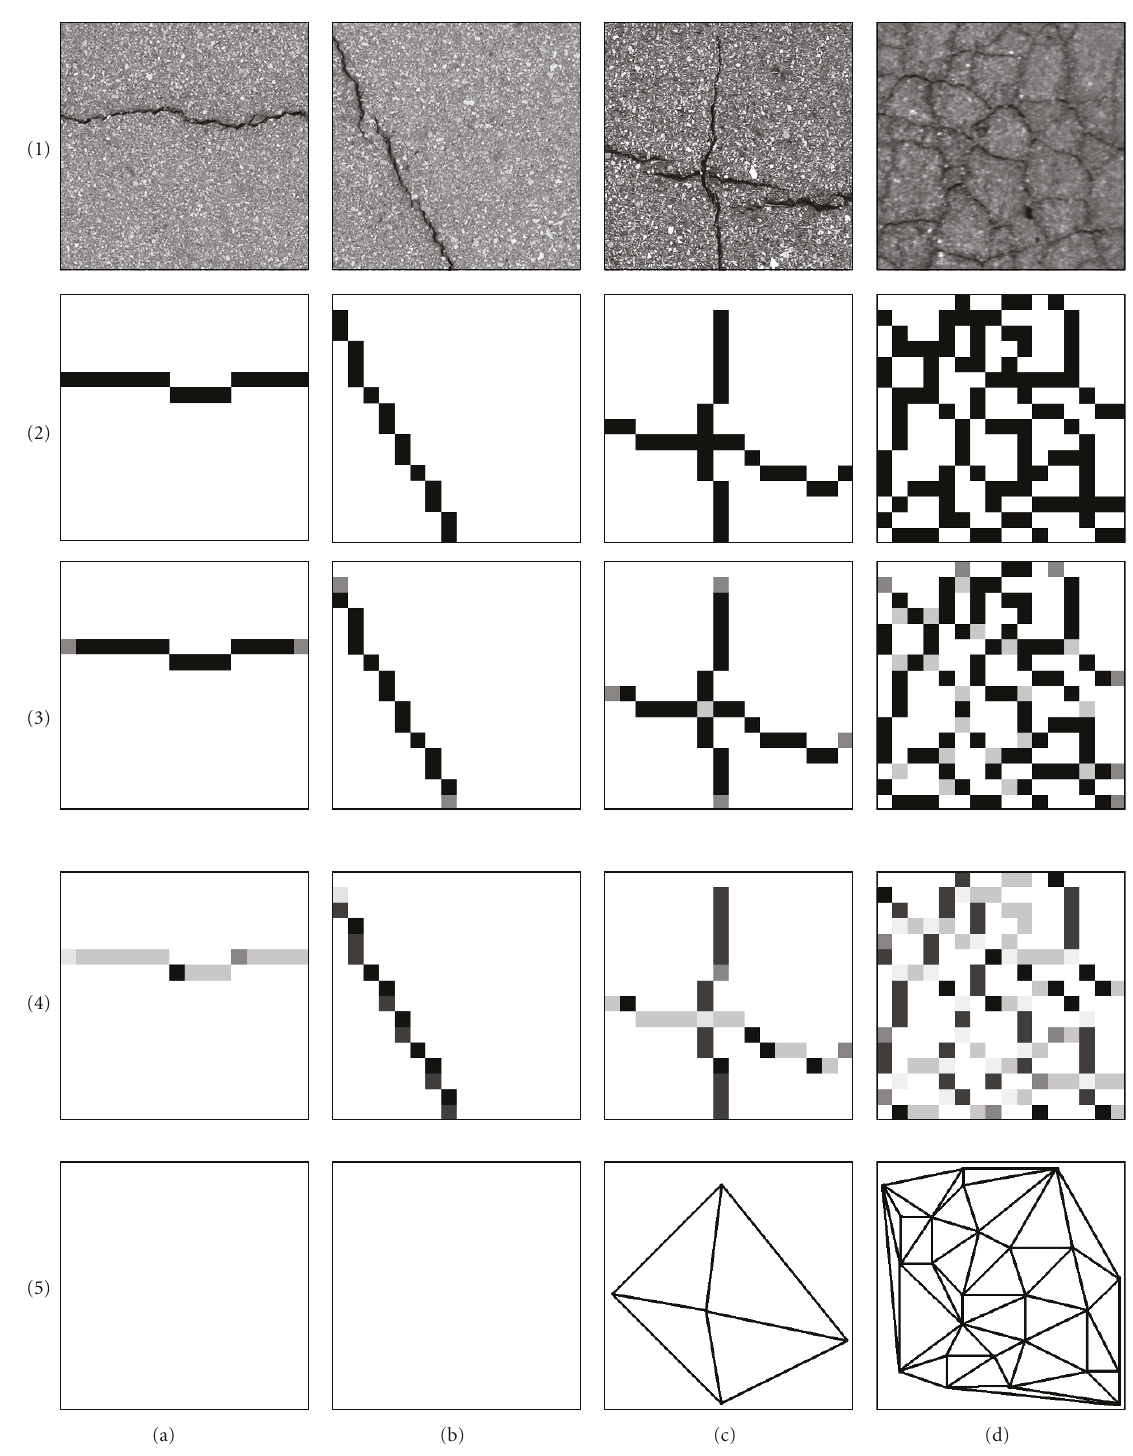
Figure 11: Examples for spatial distribution features extraction. Row 1 shows the source pavement images with di ff erent crack types. Row 2 displays the corresponding binary skeletons of the crack sections. Row 3 gives the result images from the process of singularity point detection, where the endpoints and junction points are labeled gray. Row 4 shows the D-Coding results of each crack subsections, in which four gray level stands for four di ff erent kinds of direction code. Row 5 shows the Delaunay triangles generated from the singularity